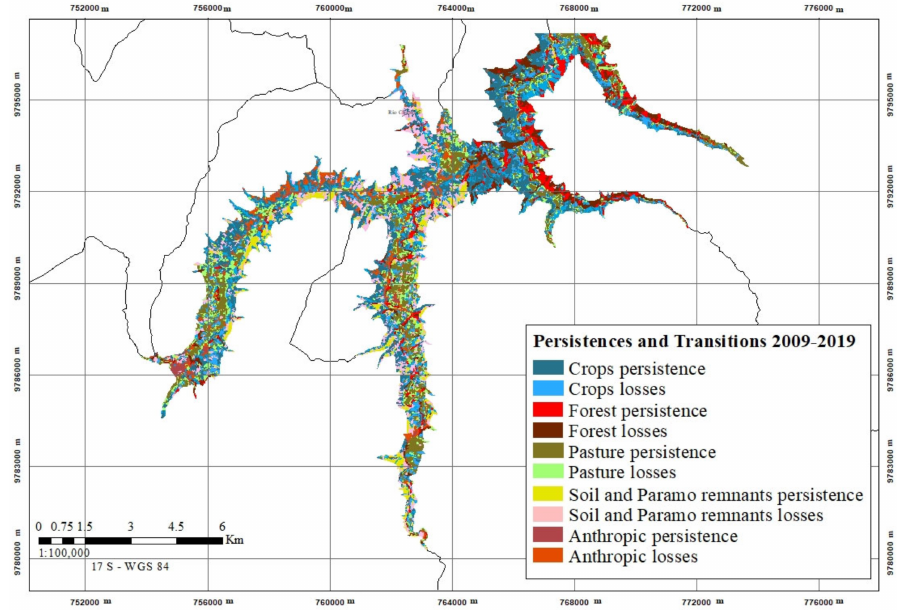
Figure 6. Map of coverage persistence and transitions between 2009 and